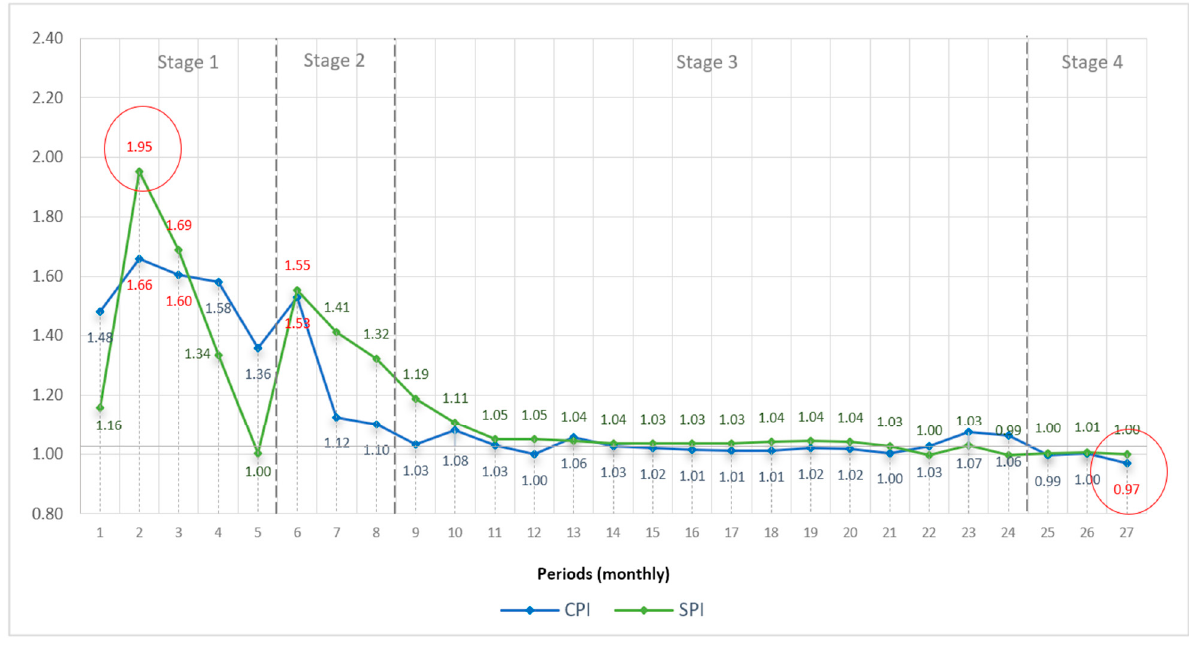
Figure 4. CPI and SPI performance indexes: Project 001 (source: Proaño-Narváez). Stage 1: The indicator SPI > 1.0 indicates that the project is well ahead of schedule. In